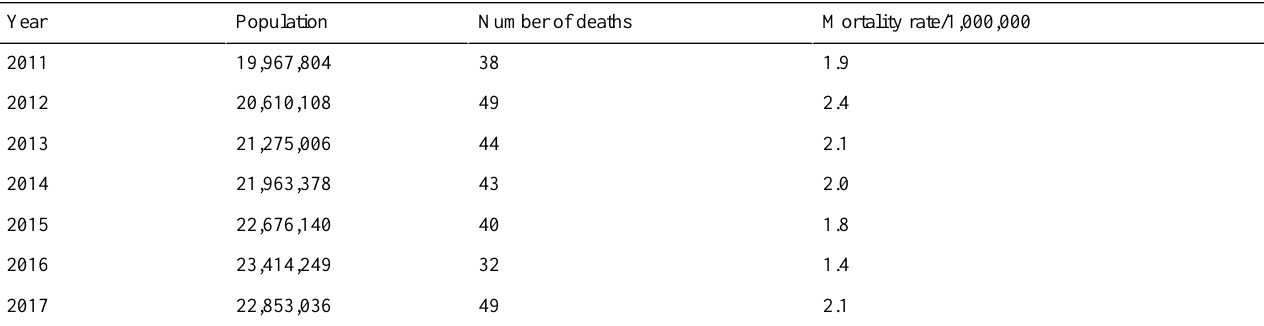
Table 1. Mortality rates from rabies in Yemen from 2011 to